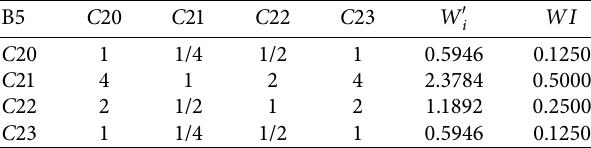
Table 7: B 5- C judgment